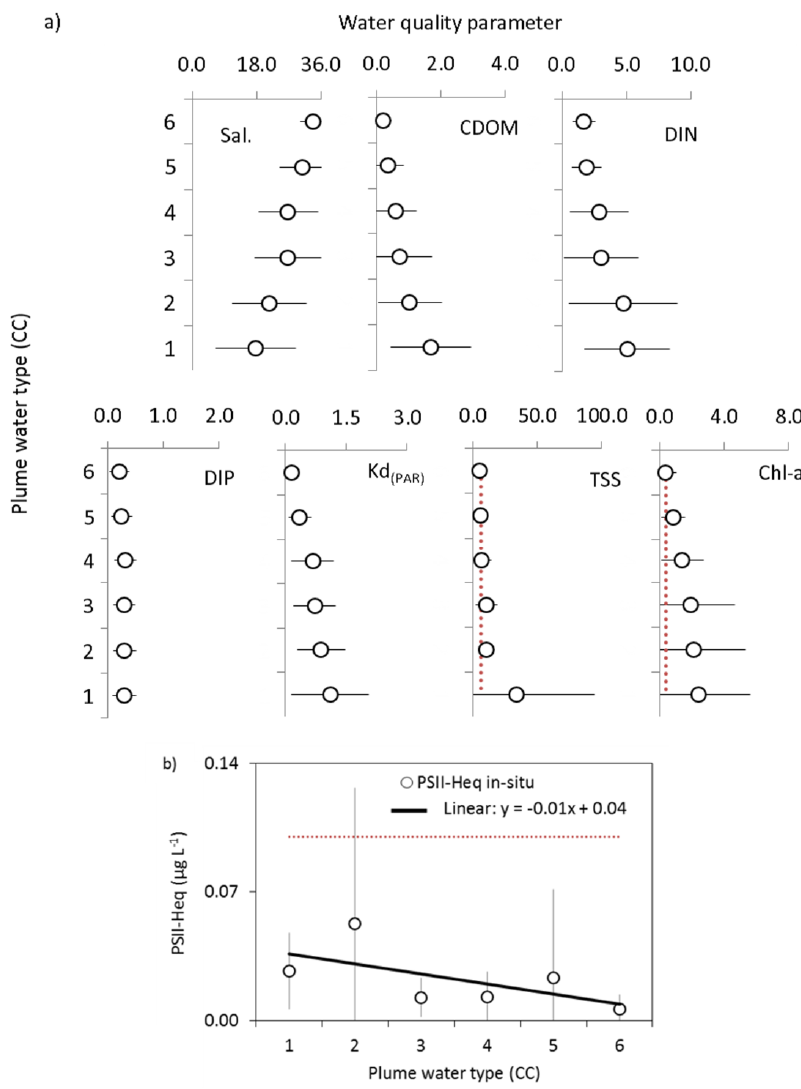
Figure 6. ( a ) Mean and standard deviation of water quality concentrations measured in the plume water types (CC1–CC6): Salinity (Sal), CDOM in m − 1 , DIN and DIP in μ mol·L − 1 , K d (PAR) in m − 1 , TSS in mg·L − 1 and Chl-a in μ g·L − 1 ; ( b ) Mean and standard deviation of measured PSII and fitted linear model. Ecological thresholds for TSS (7 mg·L − 1 ), Chl-a (0.45 μ g·L − 1 ) and PSII (0.1 μ g·L − 1 ) are indicated with red dotted lines. Numerical values are in the supplementary material (Table S5).